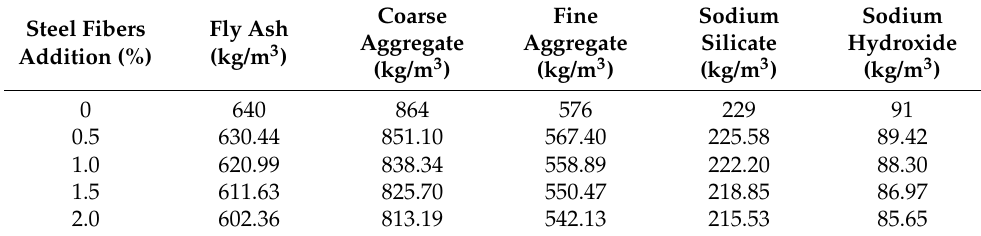
Figure 1. Steel fibers: ( a ) Hook fibers and ( b ) straight fibers. Table 1. Mix design of steel fiber reinforced geopolymer concrete.